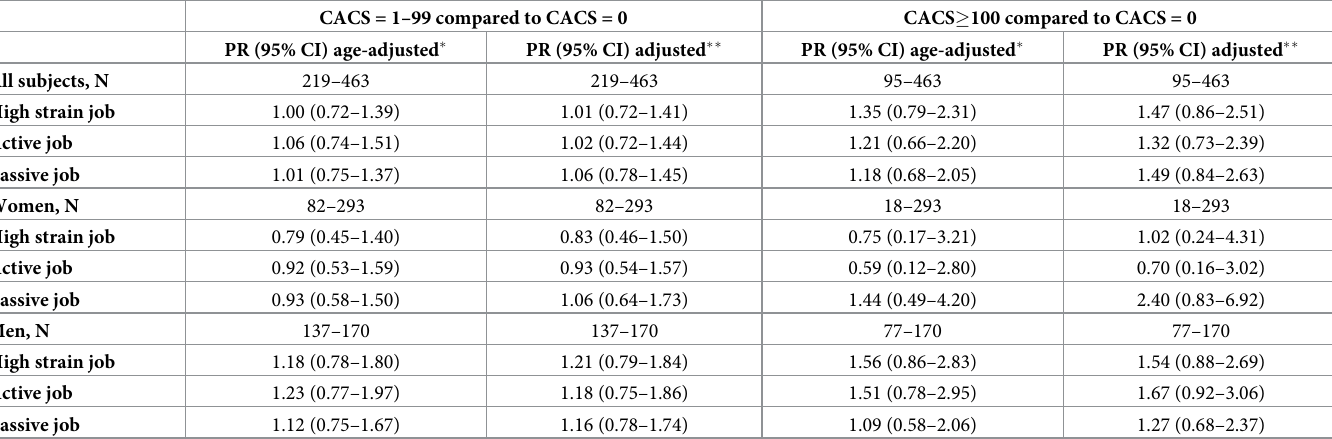
Table 2. Prevalence Ratios (PR) with 95% confidence intervals (CI) between exposure to job demand-control and CACS. CACS = 1–99 compared to CACS = 0 CACS � 100 compared to CACS =